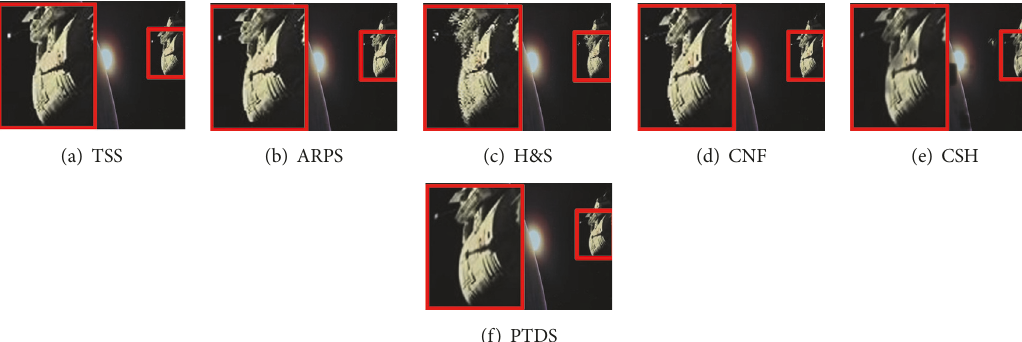
Figure 7: Interpolation frame 38 of sequence